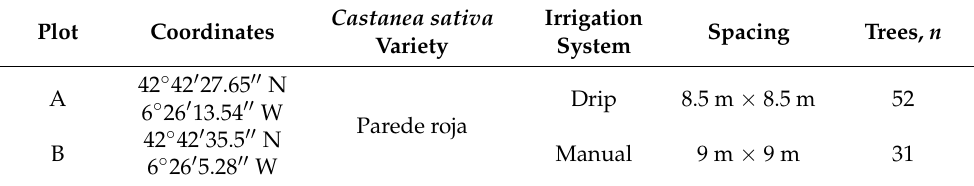
Table 1. Main plot